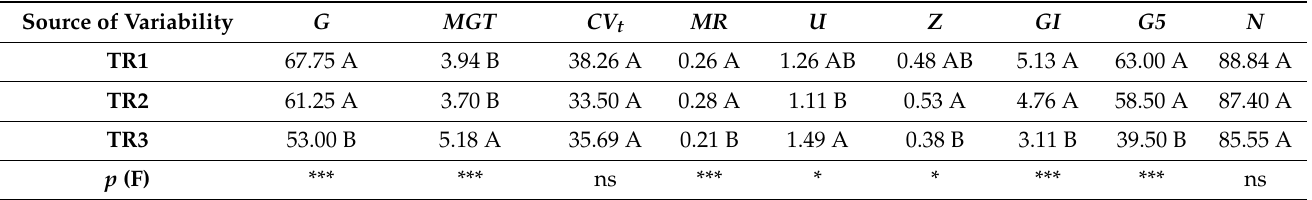
Table 6. Differences between treatments for the germination parameters of natural winter savory Population 1 in the second phase of the experiment under drought